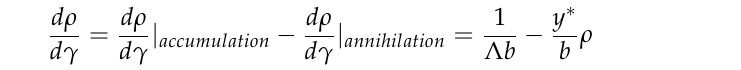
Figure 11. The average ( a ) crystallite size, ( b ) dislocation density, and ( c ) strain of CP Zr powder and as-sprayed Zr coatings (S1–S5).